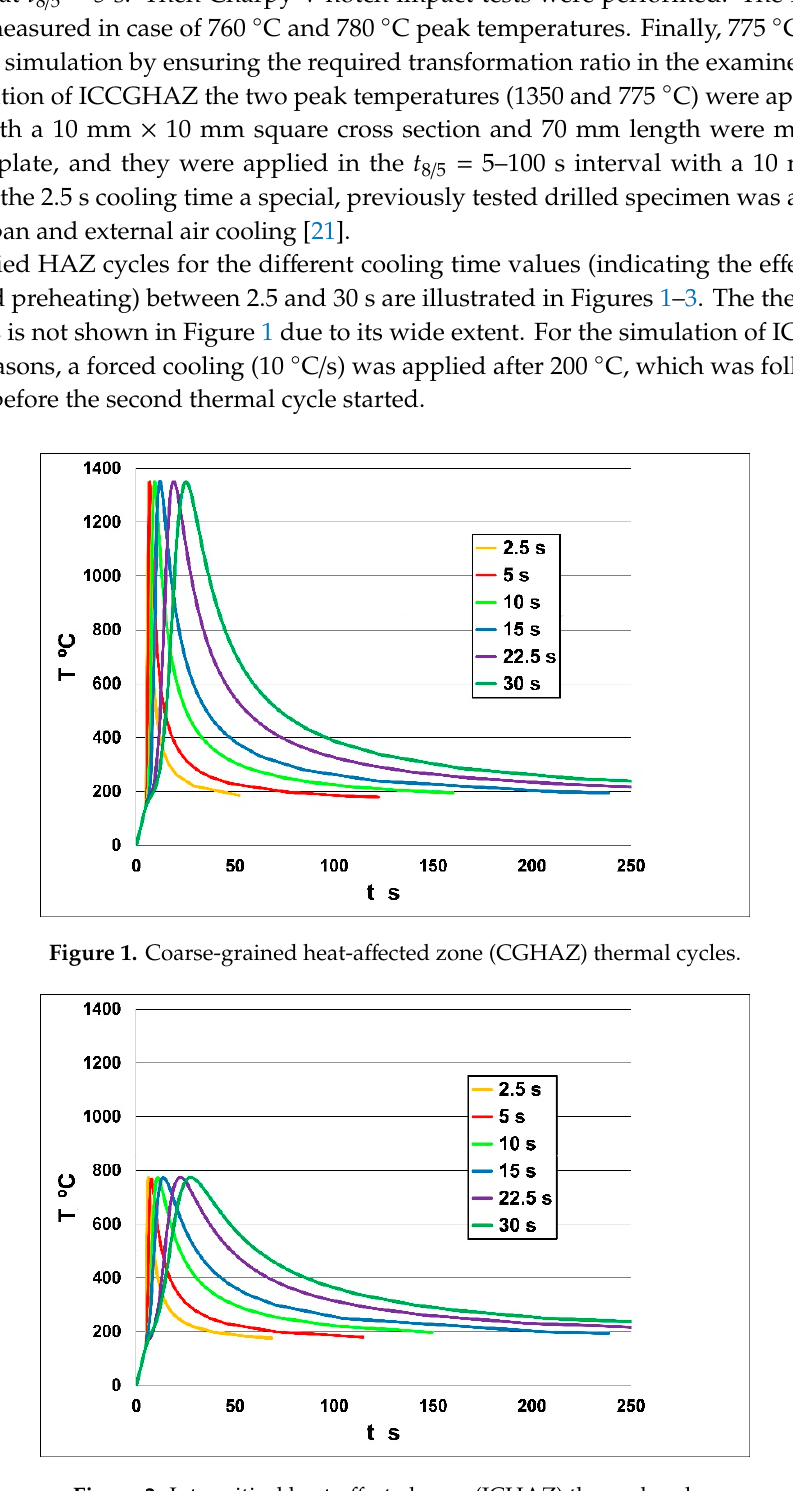
ff ected zone (ICHAZ) thermal Figure 2. Intercritical heat-affected zone (ICHAZ) thermal cycles. Figure 2. Intercritical heat-a Figure 2. Intercritical heat-affected zone (ICHAZ) thermal cycles.